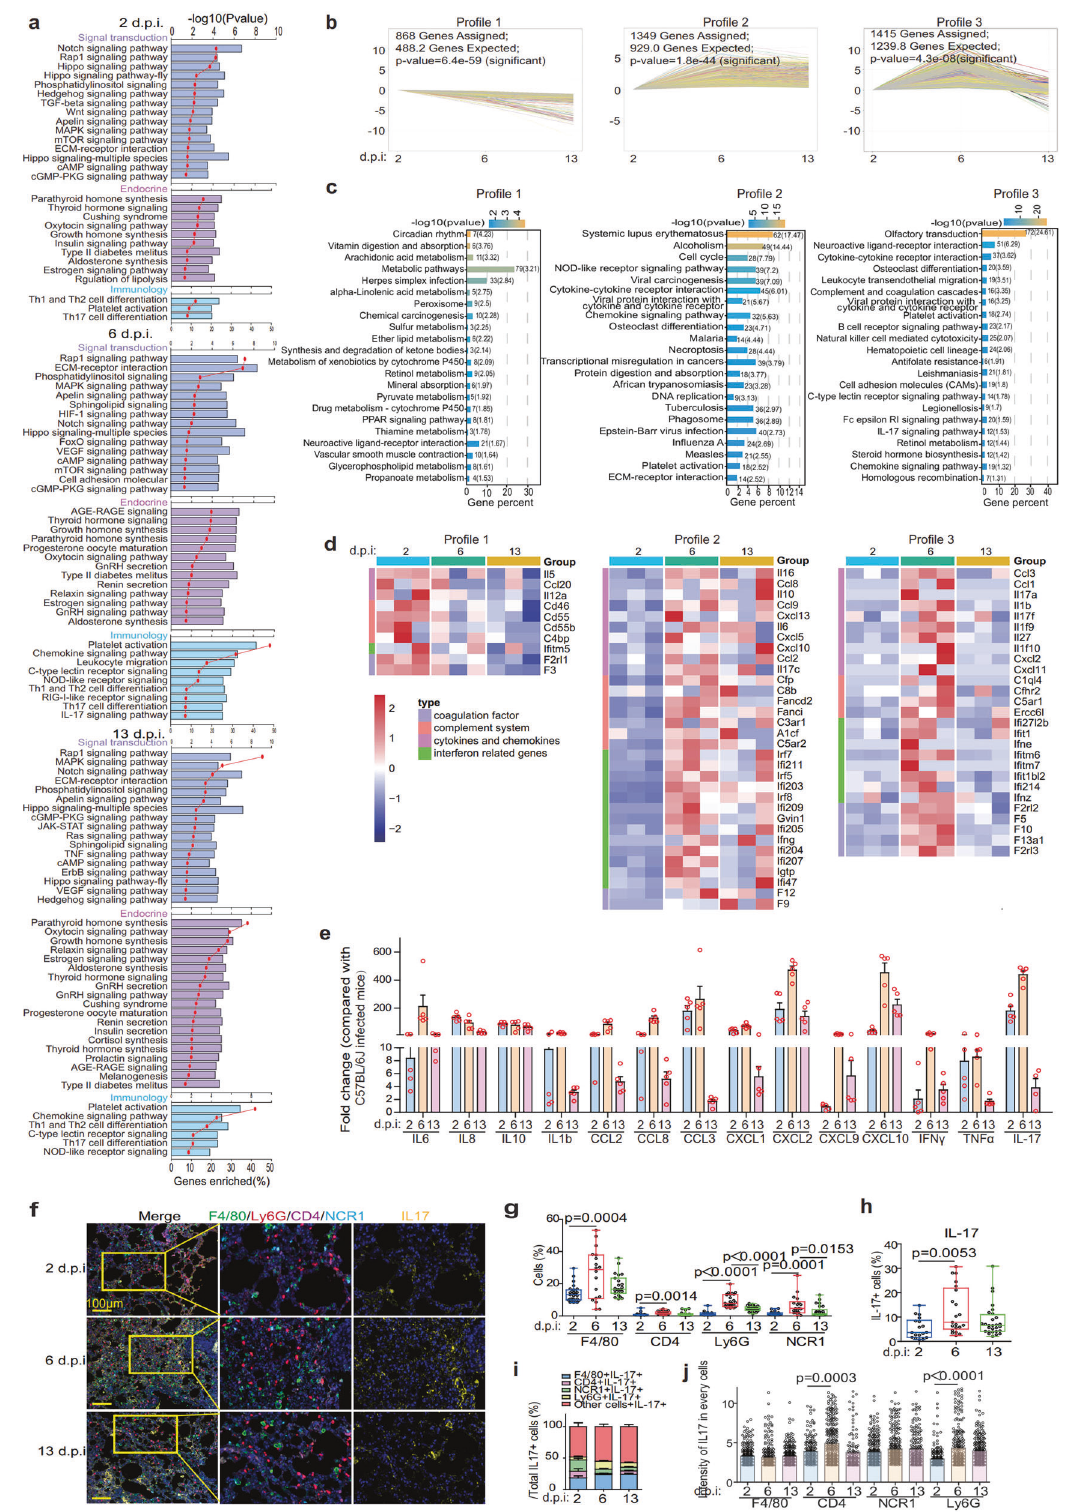
expression was enhanced by CD147 overexpression, which was inhibited by JAK inhibitor (Fig. 5c), indicating that CD147 is responsible for CyPA upregulation via JAK pathway. 30 CyPA is a ubiquitously expressed intracellular protein and is secreted in response to in fl ammatory stimuli. 31 Therefore, CyPA